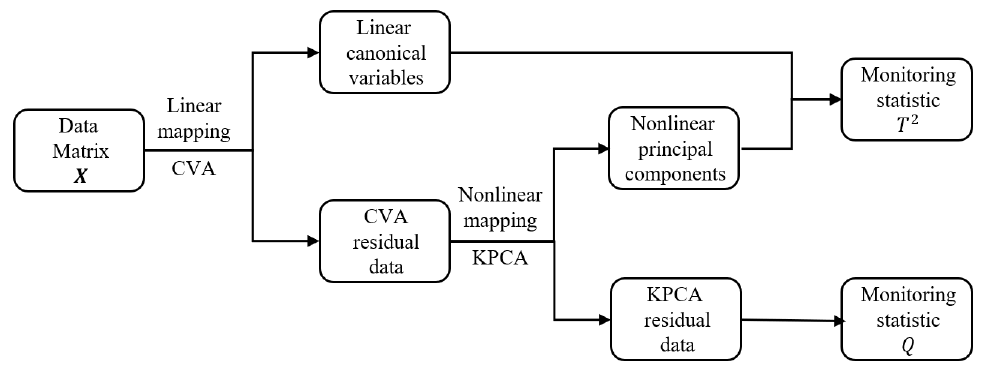
Figure 1. Schematic of CVKA-based process